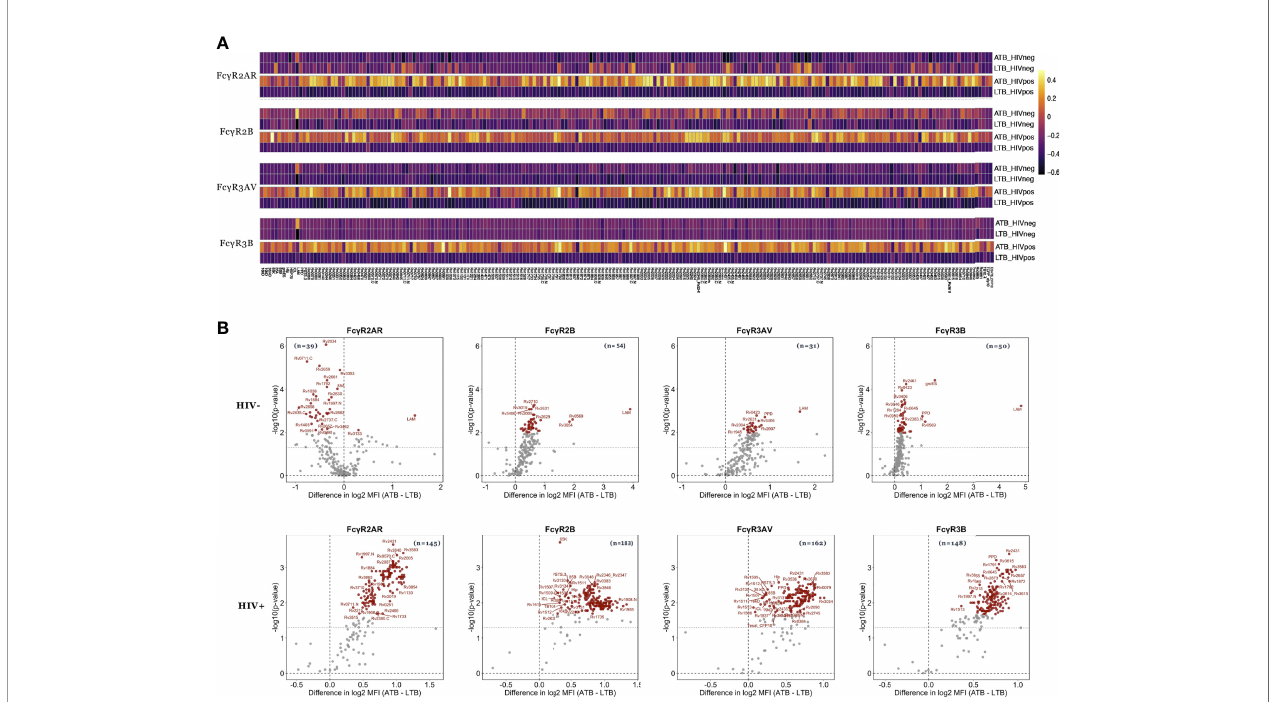
FIGURE 3 | Mtb-speci fi c FcR binding distinguishes ATB from LTB among HIV negative and positive individuals. The ability of antibodies to bind to FcgR2AR, FcgR2B, FcgR3AV and FcgR3B was measured in the plasma of ATB (n=21) and LTB (n=22) patients without HIV infection as well as ATB (n=12) and LTB (n=22) patients with HIV. (A) Heatmaps show median values of FcR binding after Z-score transformation to each of the 209 Mtb antigens. (B) Fold change between FcR binding in ATB and LTB as well as the signi fi cance ( p values) of differences are plotted the volcano plots. Values above black dashed lines are statistically different between ATB and LTB ( p < 0.05). For adjusted p values, signi fi cant data are shown in red, non-signi fi cant differences are in